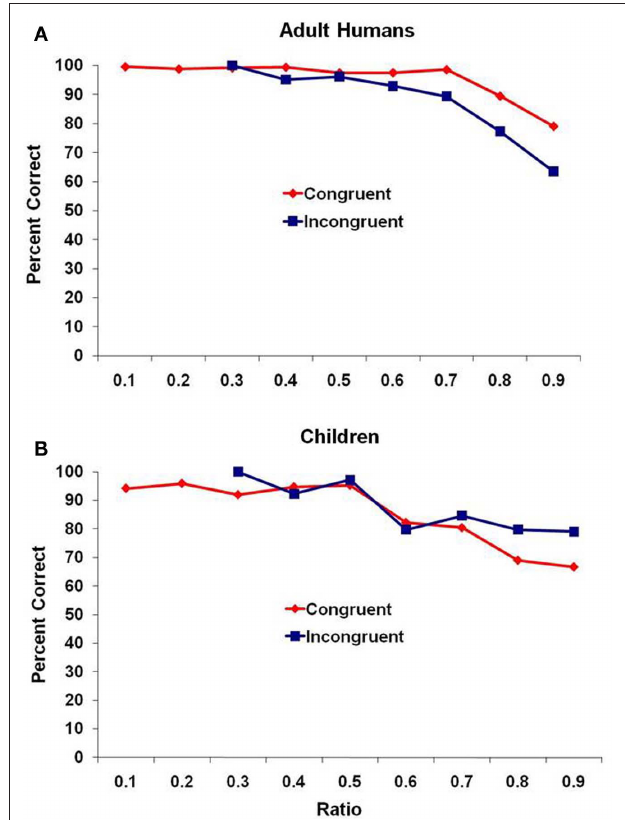
Figure 2 | Performance for (A) adult humans and (B) human children for the two trial types, presented as a function of the ratio between subsets. Data are combined across all participants because of the smaller number of trials completed by each participant compared to the